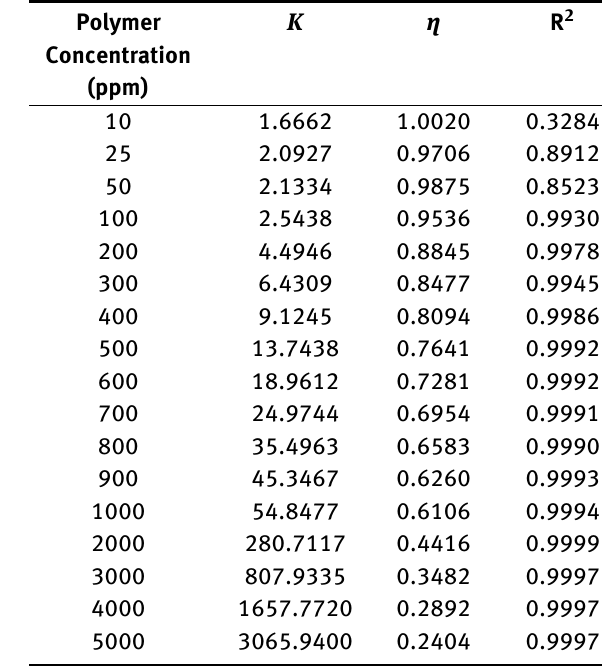
Table 5: Fit parameters to the Power Law Model for 23 ∘